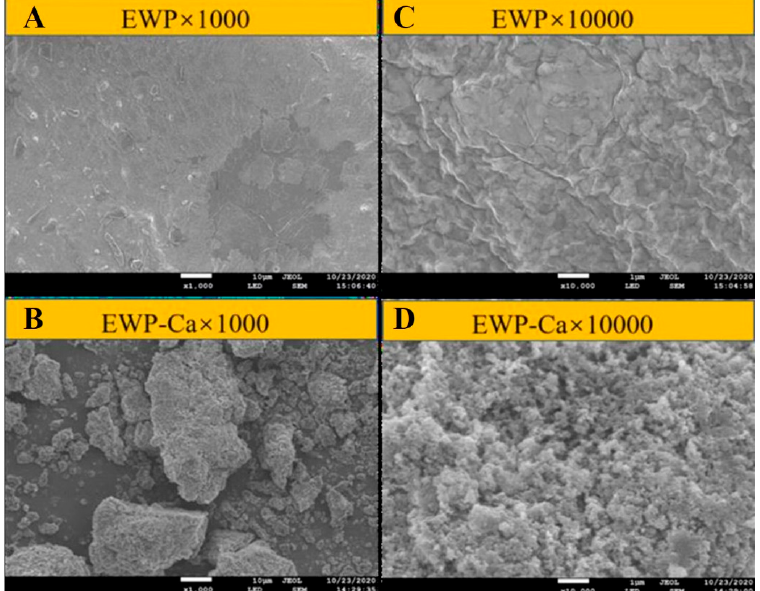
Figure 1. SEM images of EWP and EWP-Ca. ( A ) SEM image of EWP at a magnification factor of 1000 × ; ( B ) SEM images of EWP-Ca at a magnification factor of 1000 × ; ( C ) SEM images of EWP at a magnification factor of 10,000 × ; ( D ) SEM images of EWP-Ca at a magnification factor of 10,000 × . The EDS analysis is usually used to analyze the chemical composition of samples